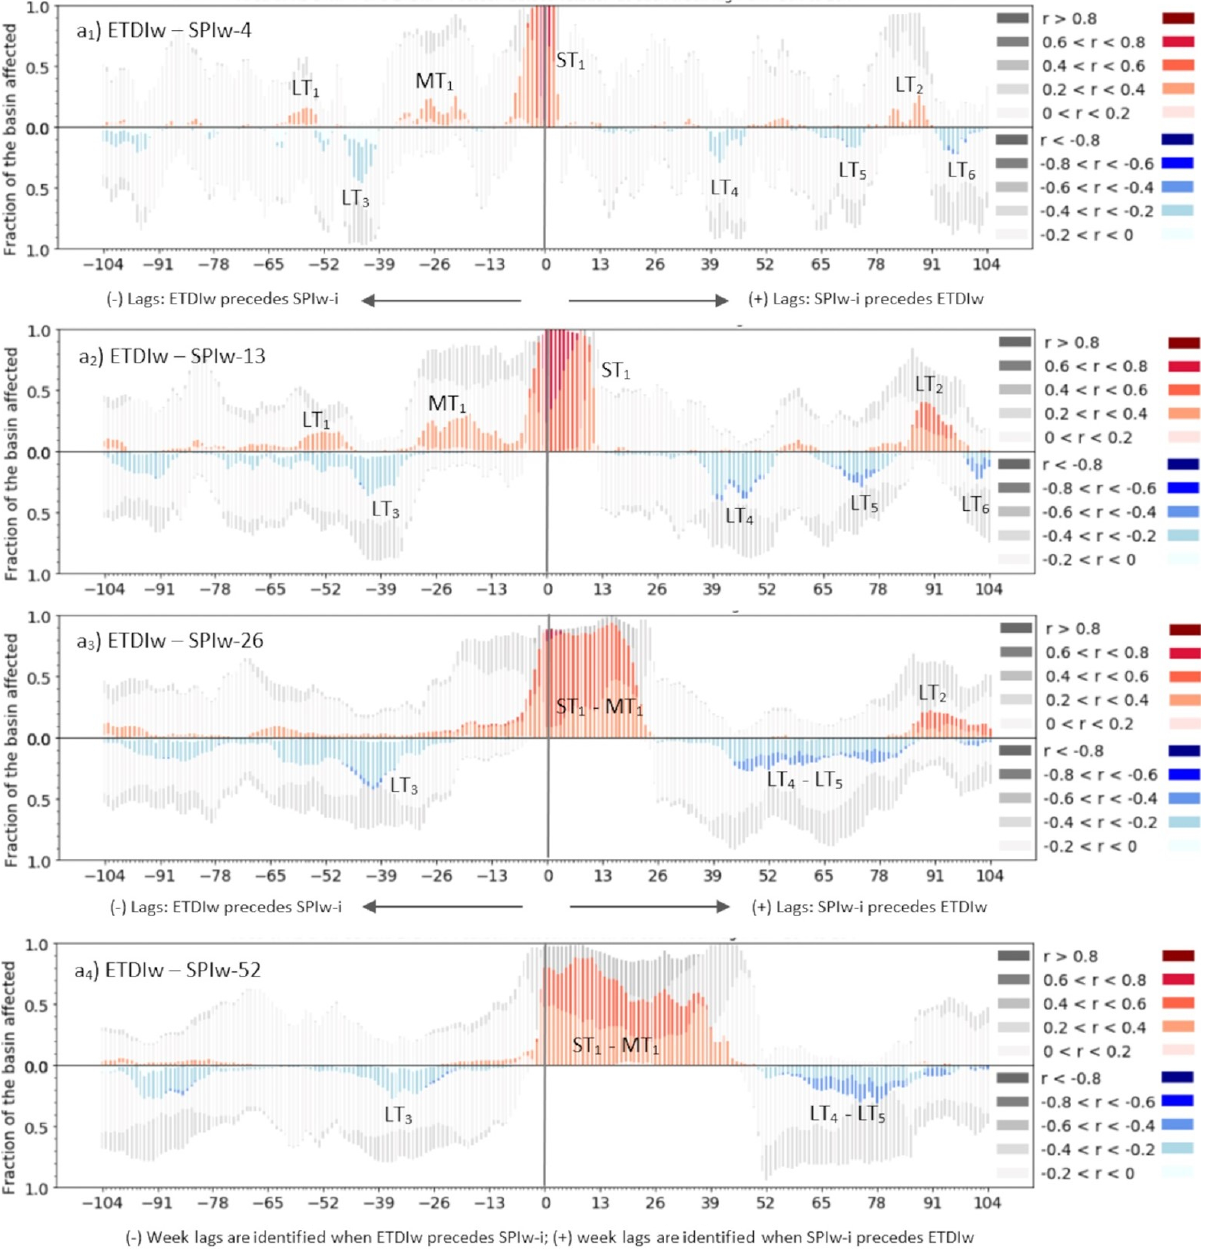
Figure 4. Lag plots of SPI-1, SPI-3, SPI-6 and SPI-12 (expressed as SPIw-4, SPIw-13, SPIw-26 and SPIw-52, respectively) with the land- surface model (LSM) ETDIw index at the weekly scale for the period 2010–2017. Lags are calculated for the − 104 leading and + 104 lagged time steps of ETDIw in reference to SPIw- i . The height of the bars of the plot indicates the area of the basin affected by non-significant (greyscale) or significant (colored scale) correlations. The saturation of the colored scale indicates the magnitude of the significant positive (red) or negative (blue) Pearson correlation coefficient of SPIw- i and